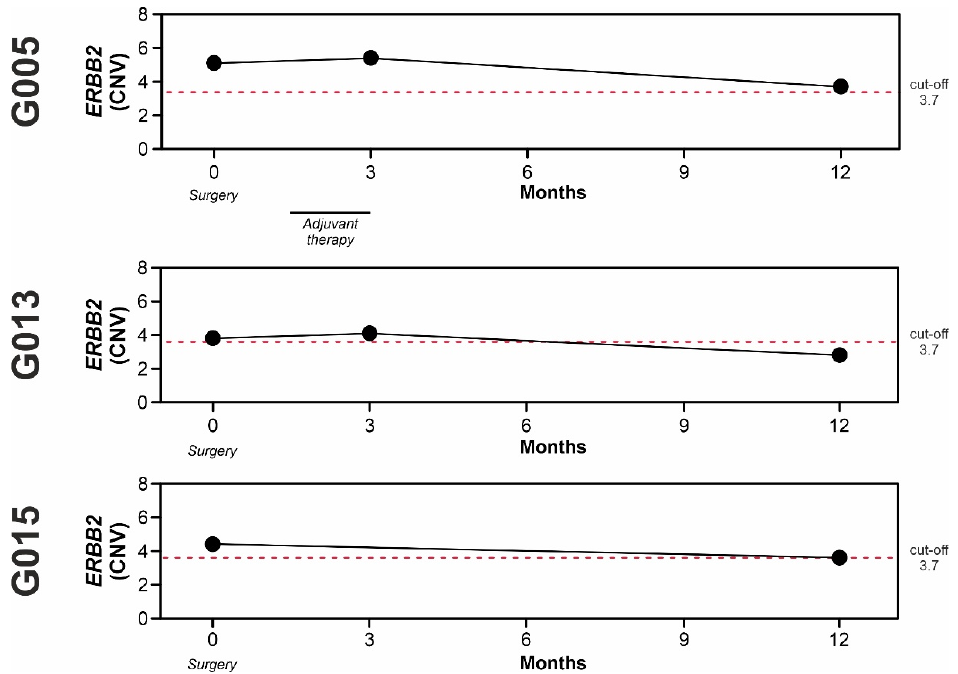
Figure 6. Longitudinal analysis of three “non-progressor” GEA patients (G005, G013, and G015). ERBB2 CNV values are reported for each patient at different time points. The administration of adjuvant therapy and surgery is indicated.